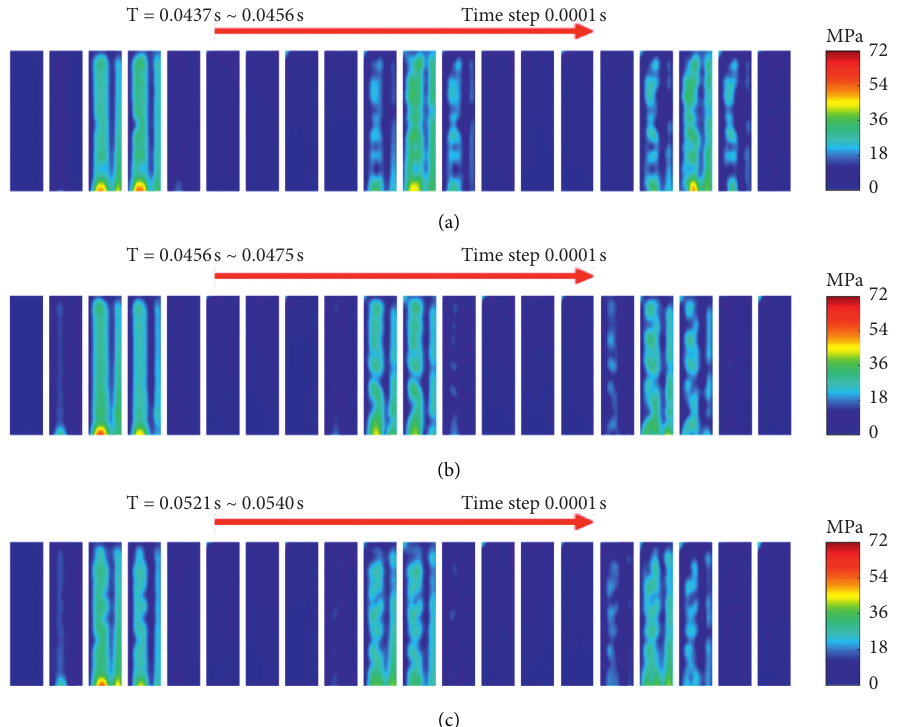
Figure 23: Phase I: Real-time stress distribution of the contact area on axle spline surface under identical loading case, at φ � 0.01 ° , 0.02 ° , and 0.04 ° . (a) Real-time stress status with circumferential misalignment φ � 0.01 ° under 0.5m/s2 driving rate, #10 tooth. (b) Real-time stress status with circumferential misalignment φ � 0.02 ° under 0.5m/s2 driving rate, #10 tooth. (c) Real-time stress status with circumferential misalignment φ � 0.04 ° under 0.5m/s2 driving rate, #10 tooth.